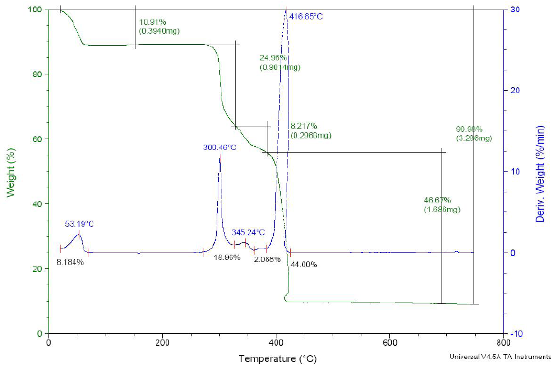
Figure 3. DSC-TGA curves for {[Cu II (cyclam)](carmoisine dianion) (H